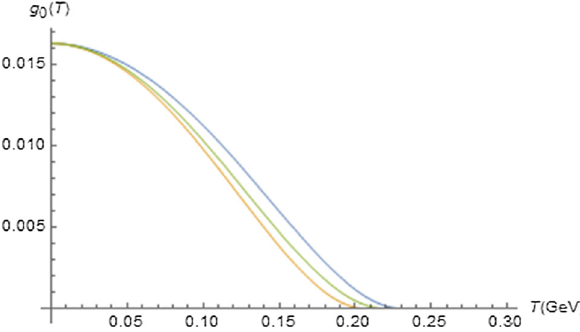
( T ) constant at N = 2, F = 87 MeV (orange line); Fig. 4 g a f 1 NN N f = 3, F = 100 MeV (green line); N f = 5, F = 140 MeV (blue line)